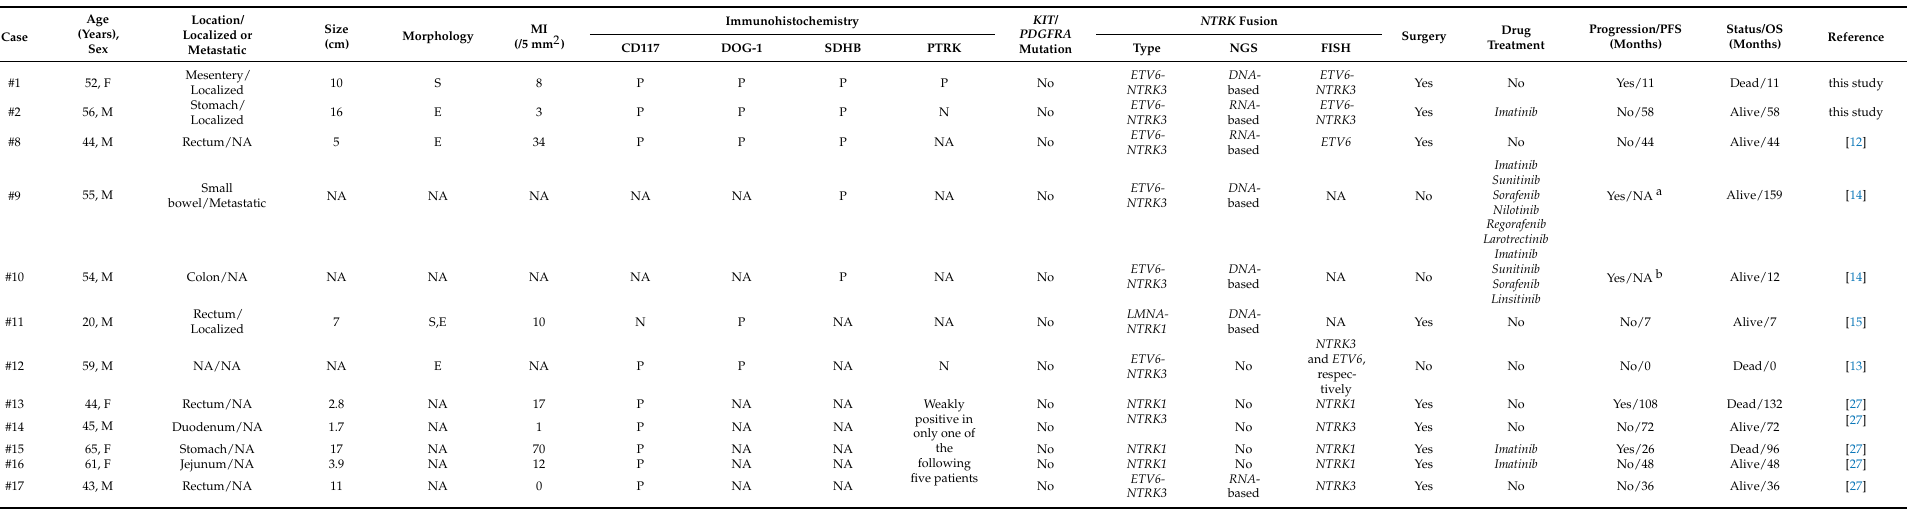
Table 2. Gastrointestinal Stromal Tumors with NTRK Gene Fusions Reported in the